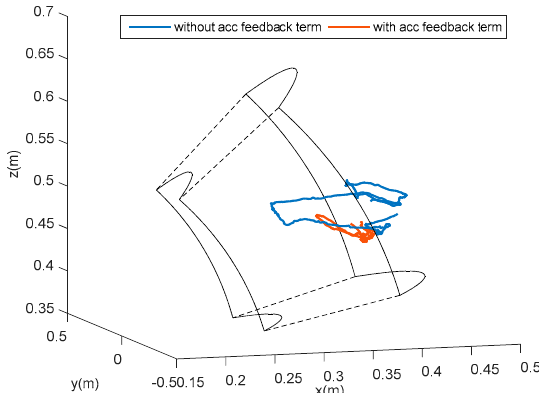
Figure 10. Target position in the operational space when hex-rotor is controlled with and without the acceleration feedback enhanced term, respectively.